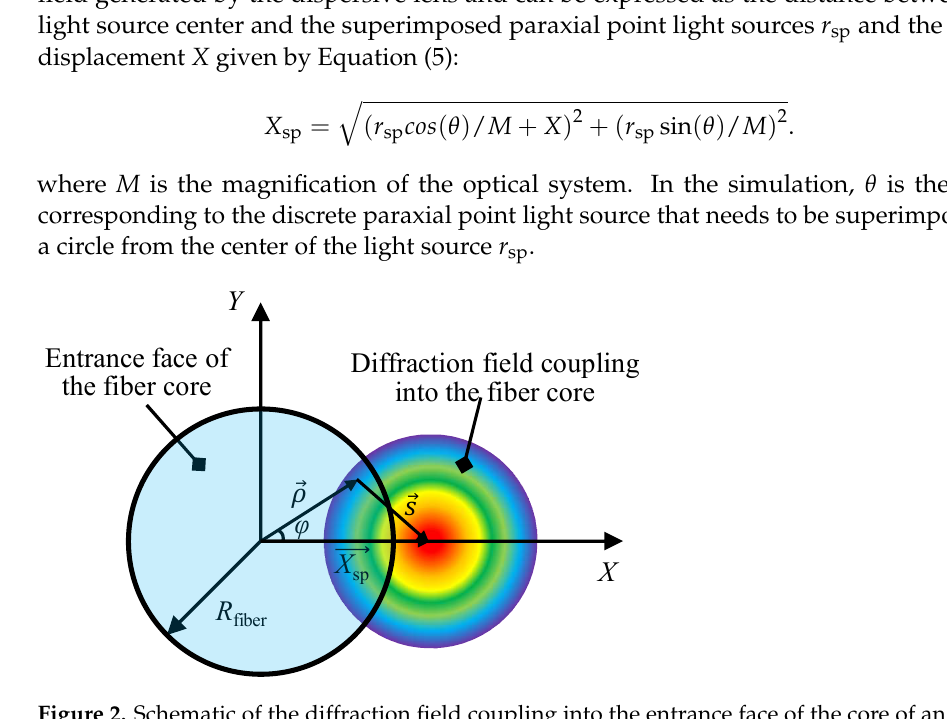
Figure 2. Schematic of the diffraction field coupling into the entrance face of the core of an optical fiber and the corresponding coordinate system in the entrance face of the fiber core.